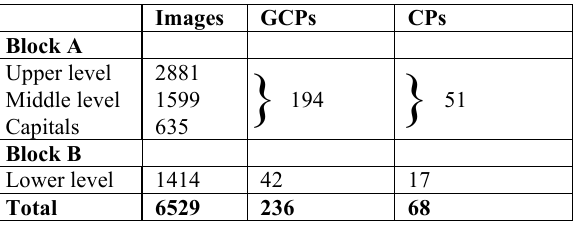
Table 2 . Images and control